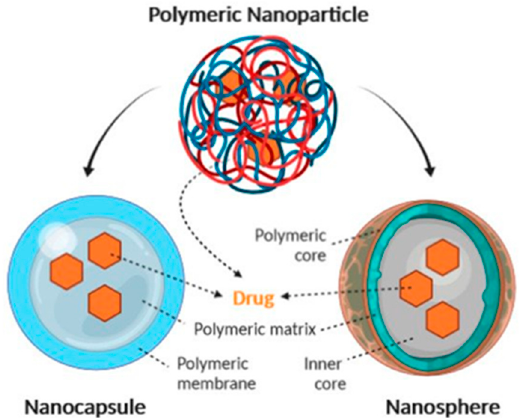
Figure 4. Schematic representation of nanocapsule and nanosphere structure [71].